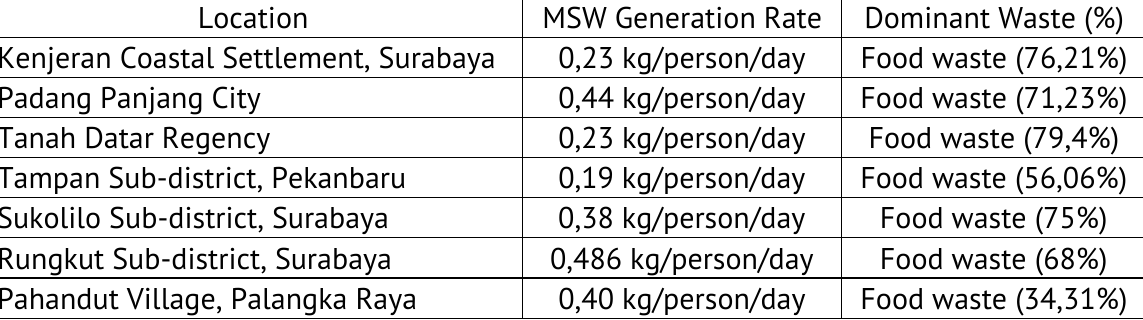
Generation Rate and Composition of MSW in Indonesia